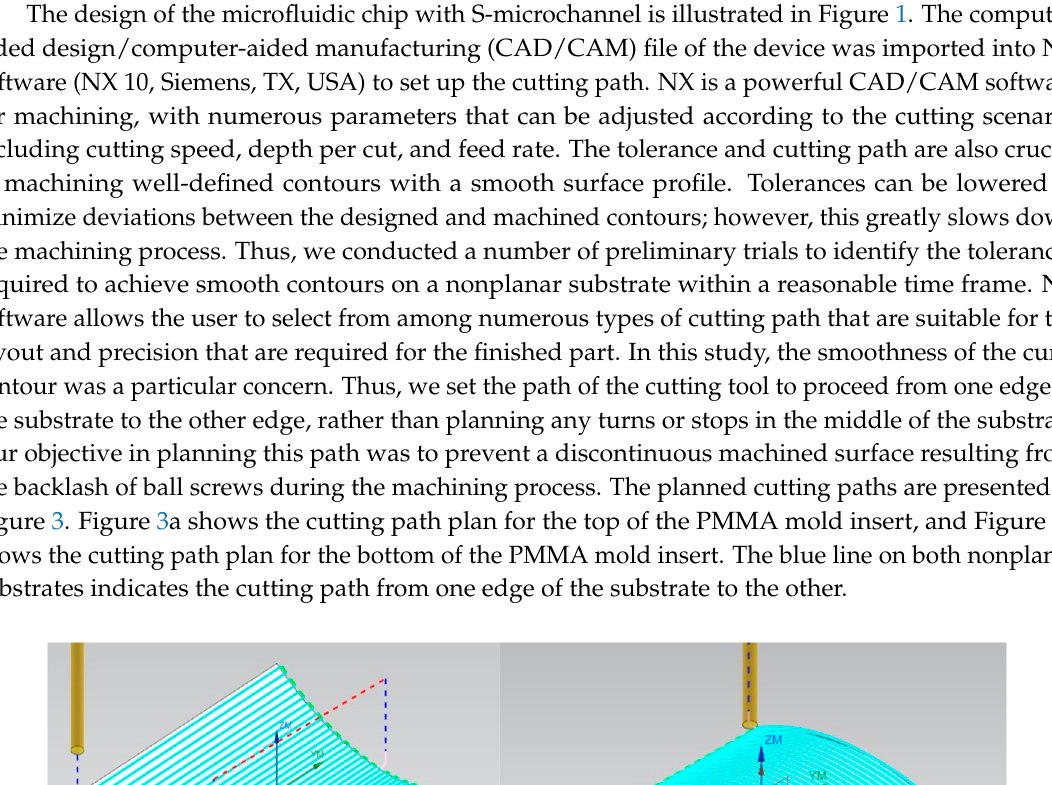
Figure 2. Microfabrication of nonplanar microfluidic chip with S-microchannel: ( a ) micromachining nonplanar substrates; ( b ) fixing two assembled substrates on rotation table; ( c ) injection of ethanol solution into microchannel using pipette followed by spin-coating for uniform distribution between substrates; ( d ) exposure of assembled chip to ultraviolet (UV) irradiation; ( e ) final annealing by oven;